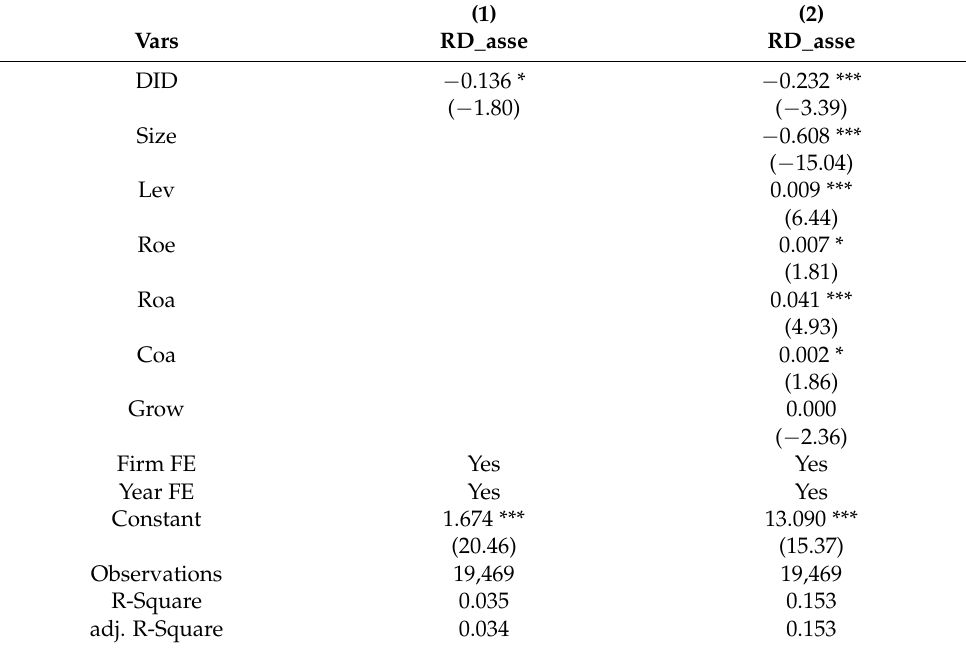
Table 2. Baseline regression results.